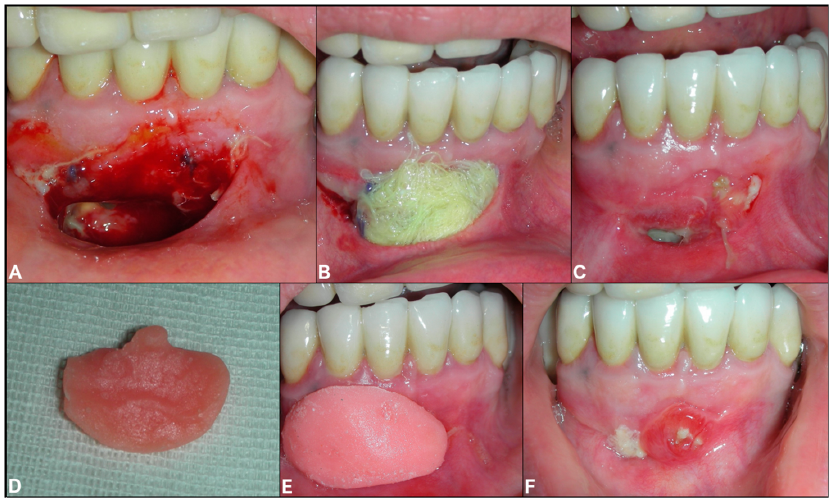
Figure 2. ( A ) Intraoral intraoperative view; ( B ) Intraoperative iodine gauze insertion; ( C ) 1 month follow-up; ( D ) Gingival view of the acrylic resin obturator; ( E ) Intraoral view of the obturator placement; ( F ) Three month follow-up.